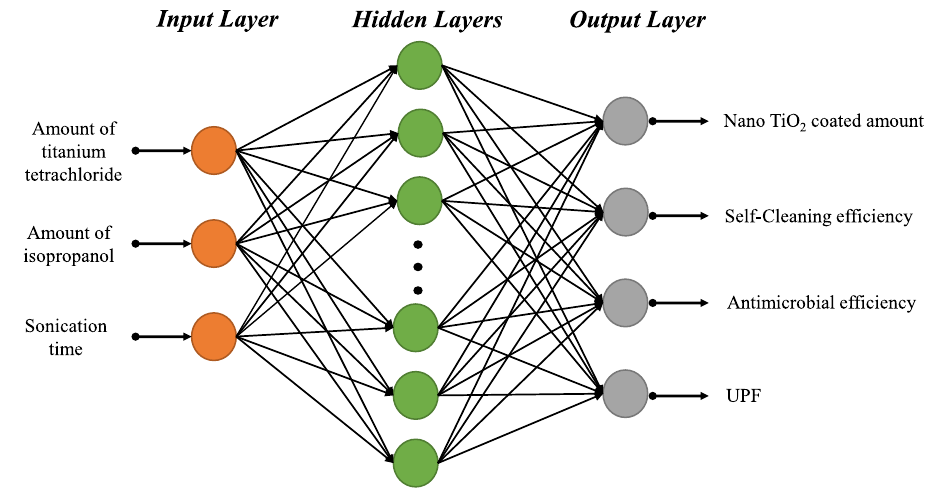
Figure 1. MLP model for the prediction of functional properties of nano TiO 2 coated